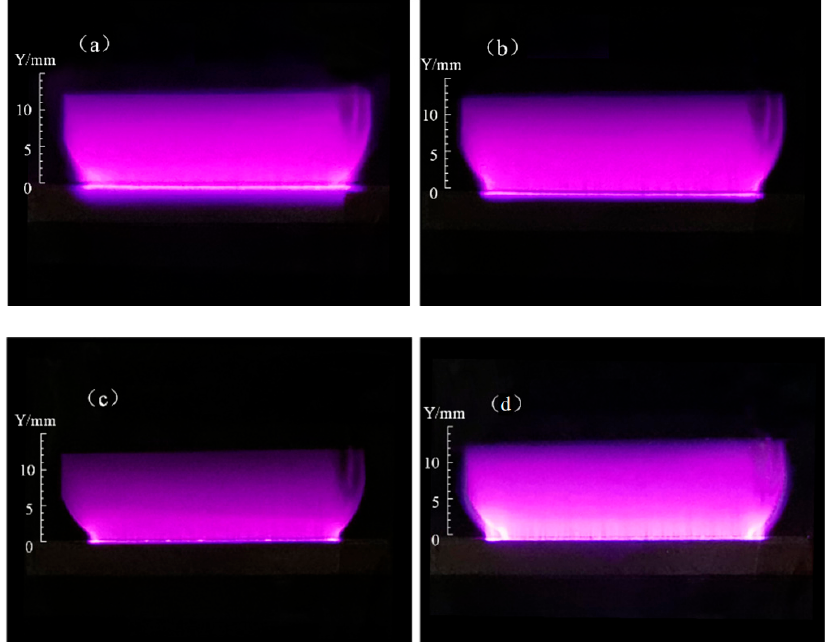
Figure 6. Emergence of filamentous discharge with increasing air pressure ( a ) 1 kPa, ( b ) 3 kPa, ( c ) 5 kPa, ( d ) 7 kPa.